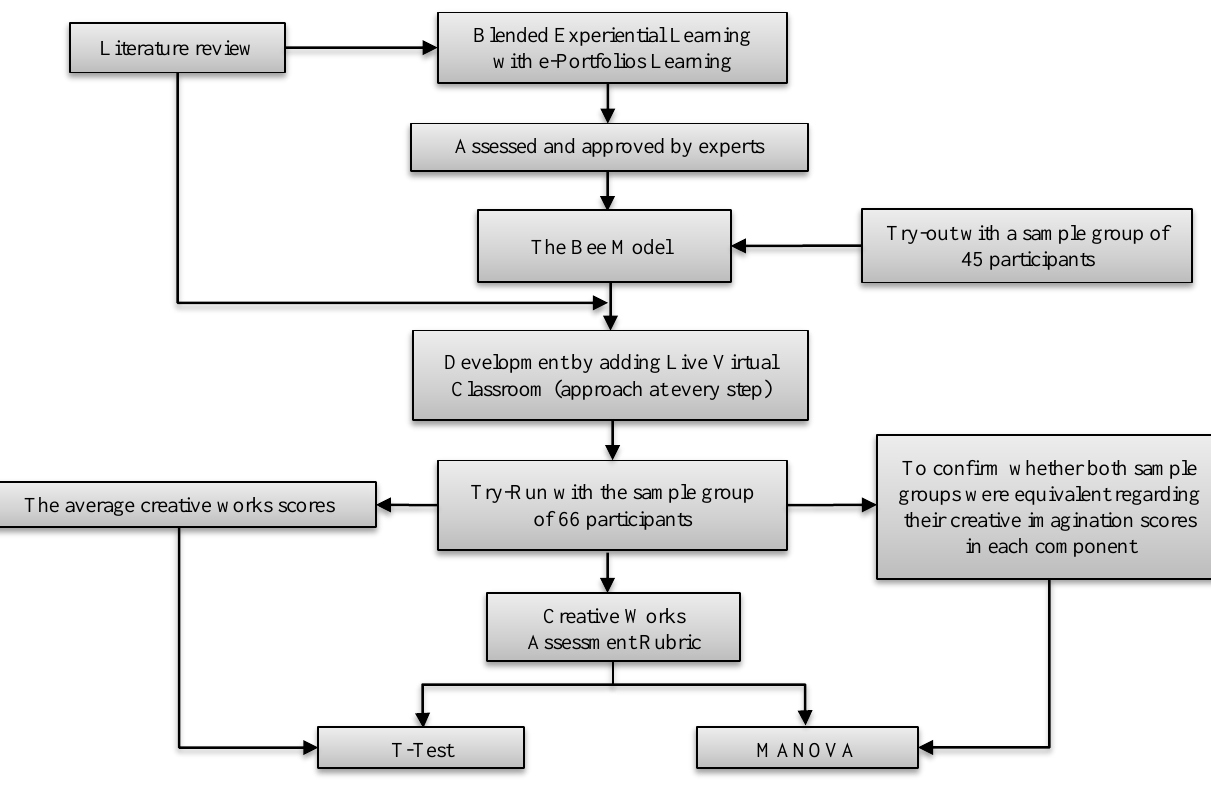
Figure 1. The flowchart to show the research methodology Table 1. The BEE model with live virtual classroom activities in each